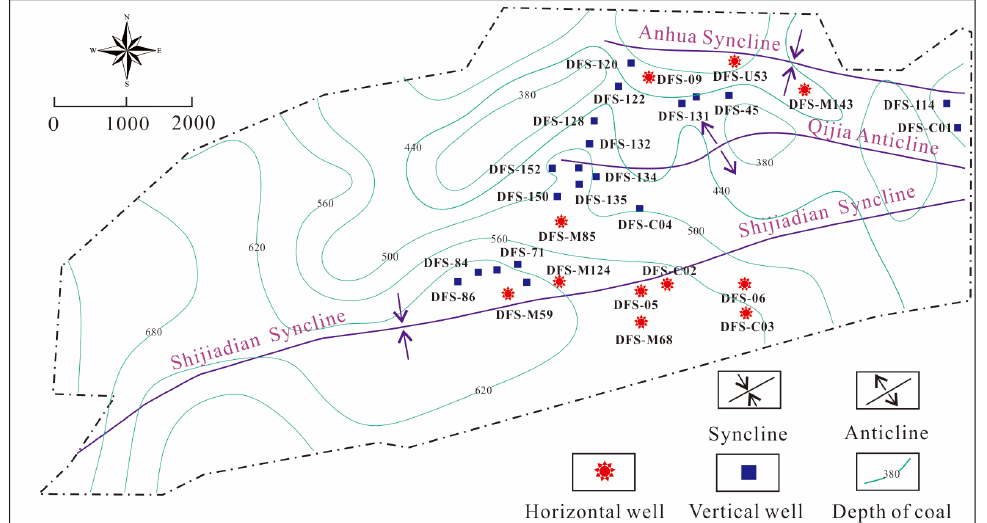
Figure 2. Structure characteristic of the study area.